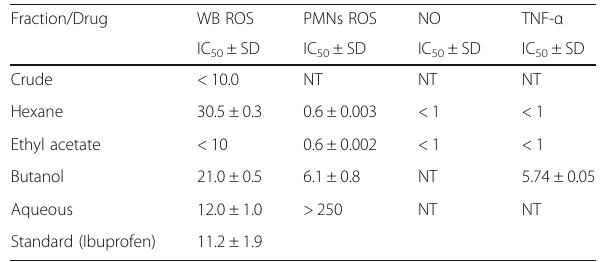
Table 2 Antiproliferative activities of methanolic crude extract and fractions of A. precatorius roots